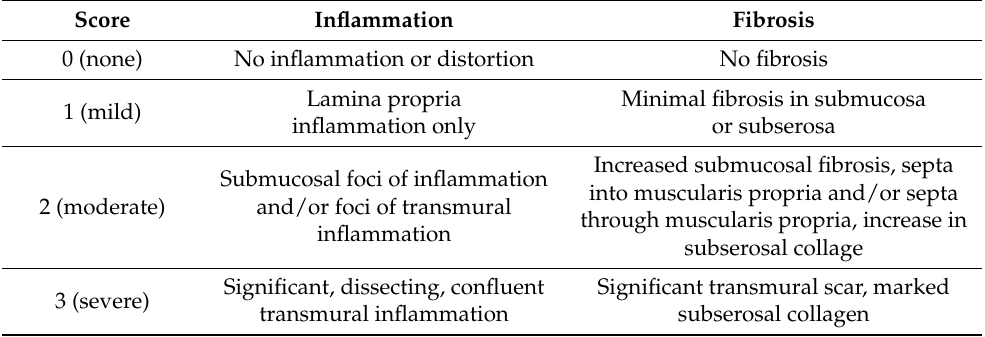
Table 2. Histologic scores for inflammatory and fibrotic Crohn’s disease.